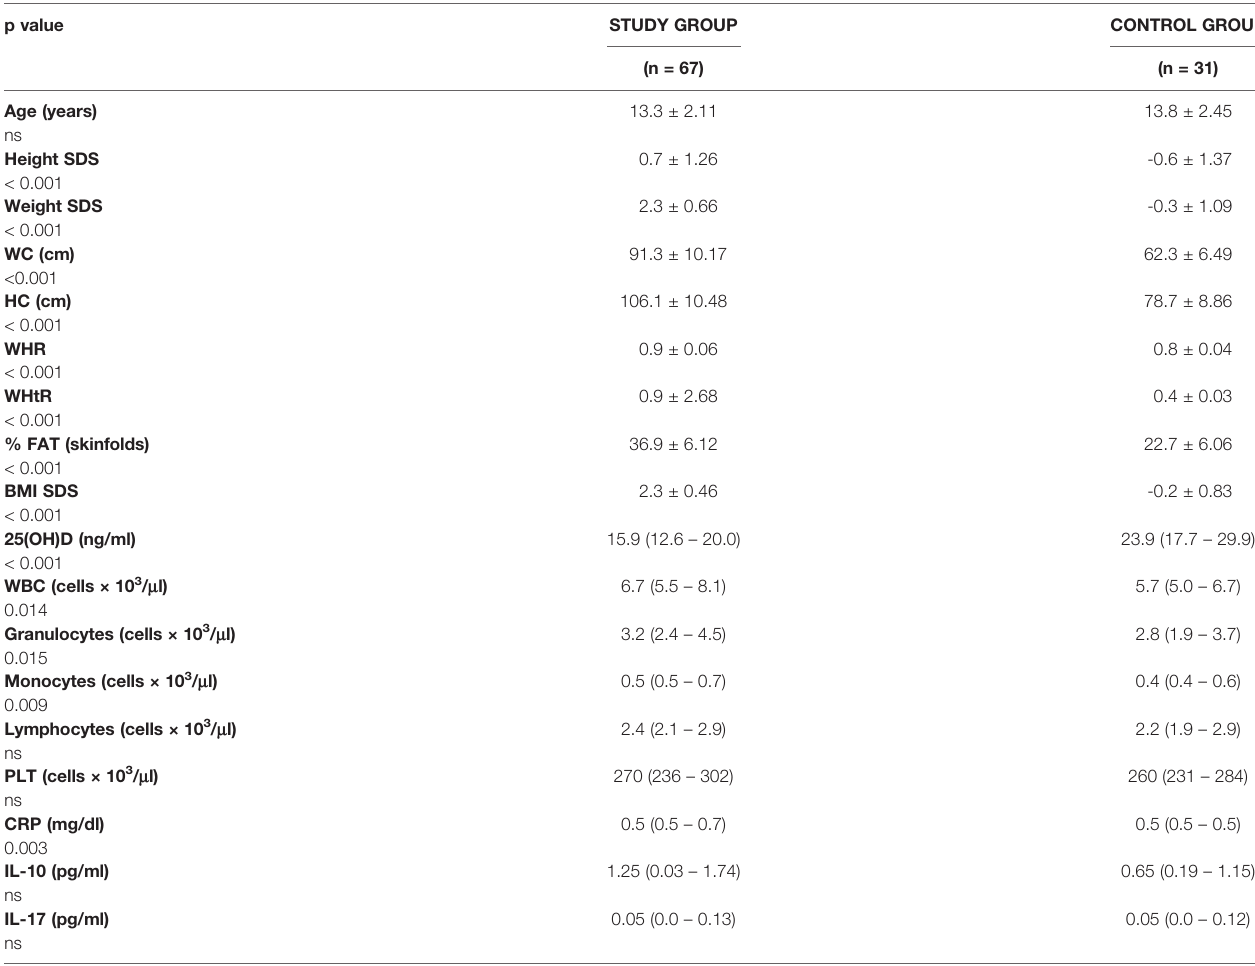
TABLE 1 | Baseline anthropometric measurements, haematological, and biochemical parameters in the study group and in the control